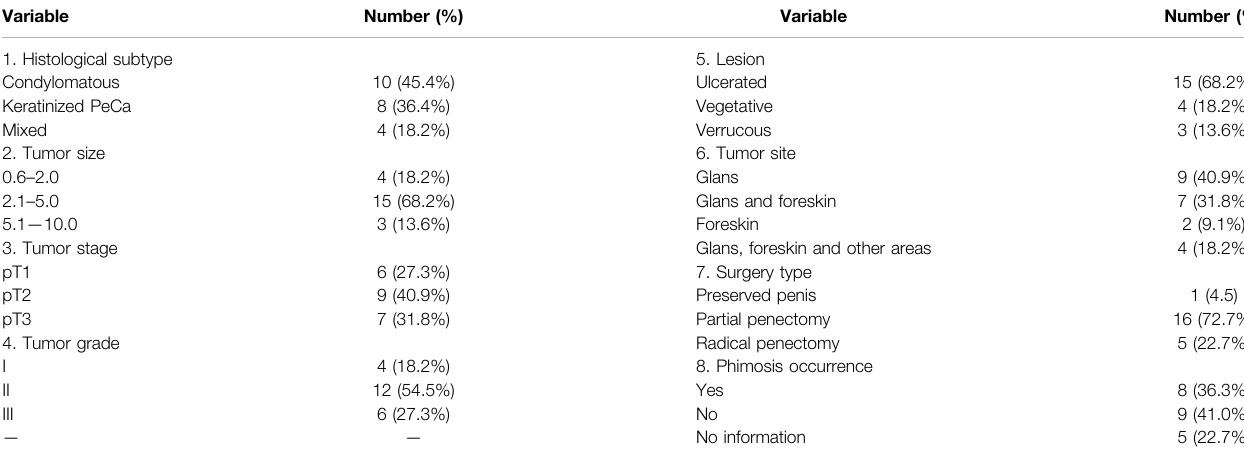
TABLE 1 | Clinical-histopathological pro fi le of patients diagnosed with HPV positive penile carcinoma ( n = 22).